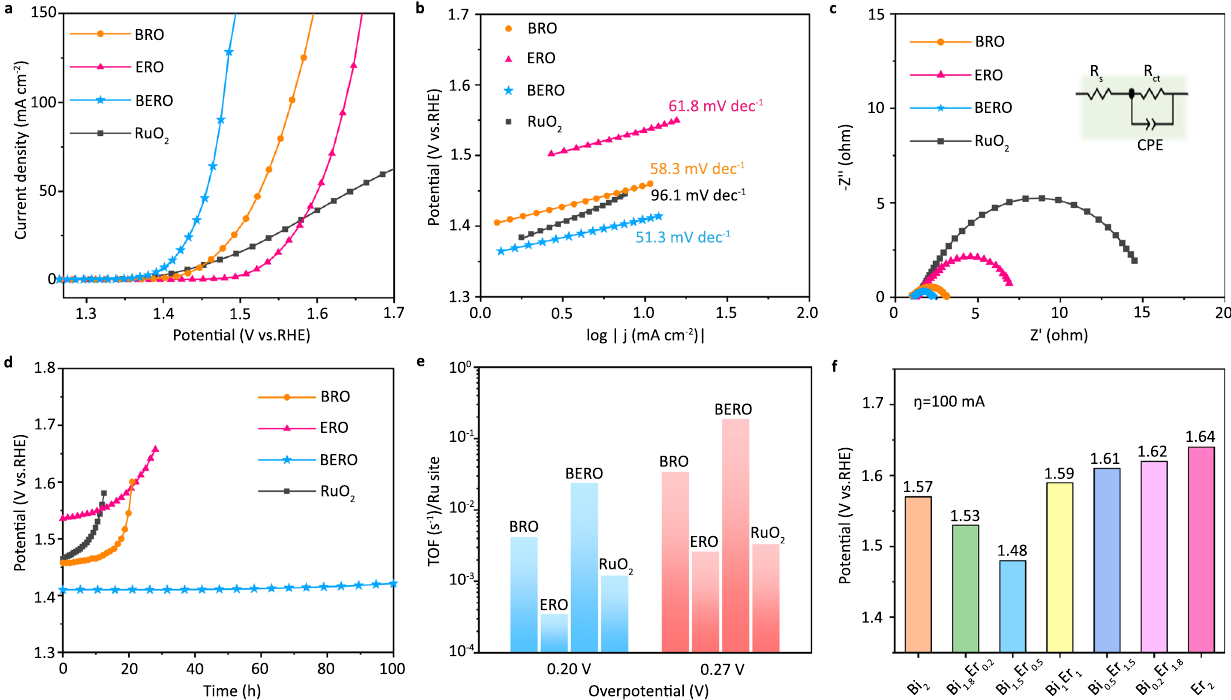
Fig. 4 Practical application of OER. a Polarization curves and ( b ) Tafel plots of the different samples. c EIS curves (Inset: the equivalent circuit.) and ( d ) Stability test of BERO, BRO, ERO and commercial RuO 2 . e TOF results at overpotential of 0.2 V and 0.27 V. f The results of the potential at 100 mA cm − 2 for Bi x Er 2-x Ru 2 O 7 with different